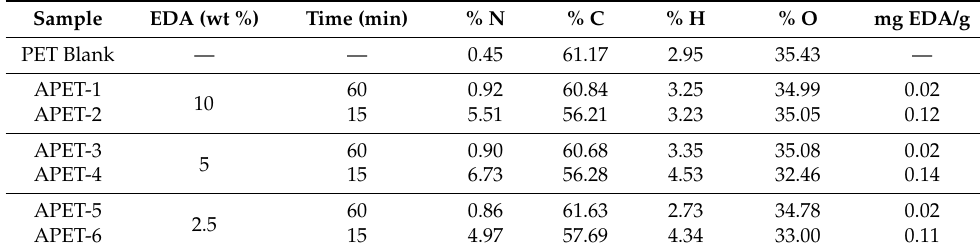
Table 3. Aminolysis conditions of the poly(ethylene terephthalate) (PET) nanofiber mats and elemental analysis for blank PET and aminated PET (APET).